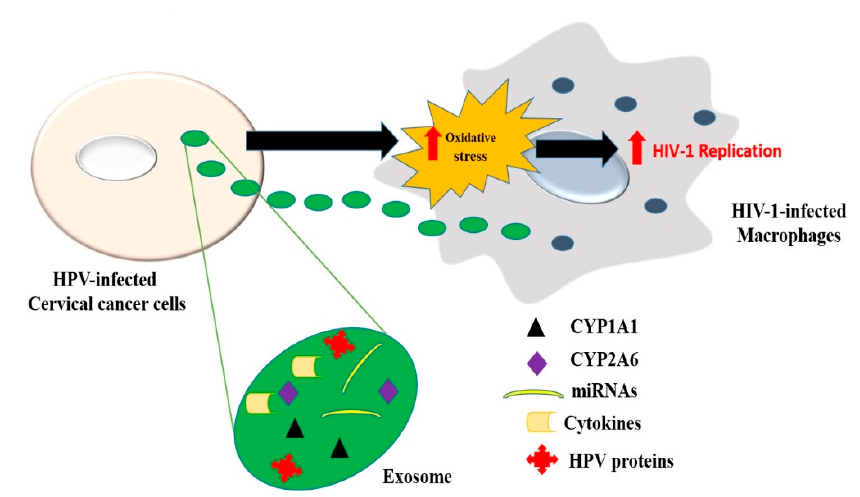
Figure 8. Proposed model for HPV–HIV-1 interaction via EVs. EVs from cervical cancer cells carry oxidative stress factors that exacerbate HIV-1 replication in HIV-1-infected macrophages. As a result of constant oxidative stress, cervical cancer cells package oxidative stress factors like CYP enzymes (CYP 1A1, 2A6, 1B1) and HPV oncoproteins, as well as potentially miRNAs and cytokines, into EVs and transfer them to cells (e.g., macrophages at distant sites). The EVs then release the oxidative stress factors in recipient cells, which further enhance ROS production in the cells. The ROS thus generated provides as a secondary messenger to trigger HIV-1 replication in macrophages.